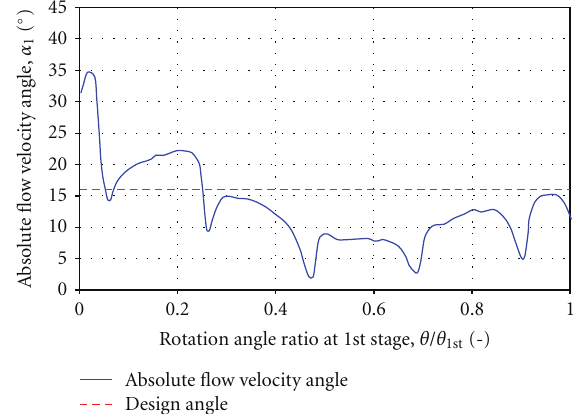
Figure 16: Absolute flow velocity angles of 1st runner stage entrance along the normalized rotation sector at design